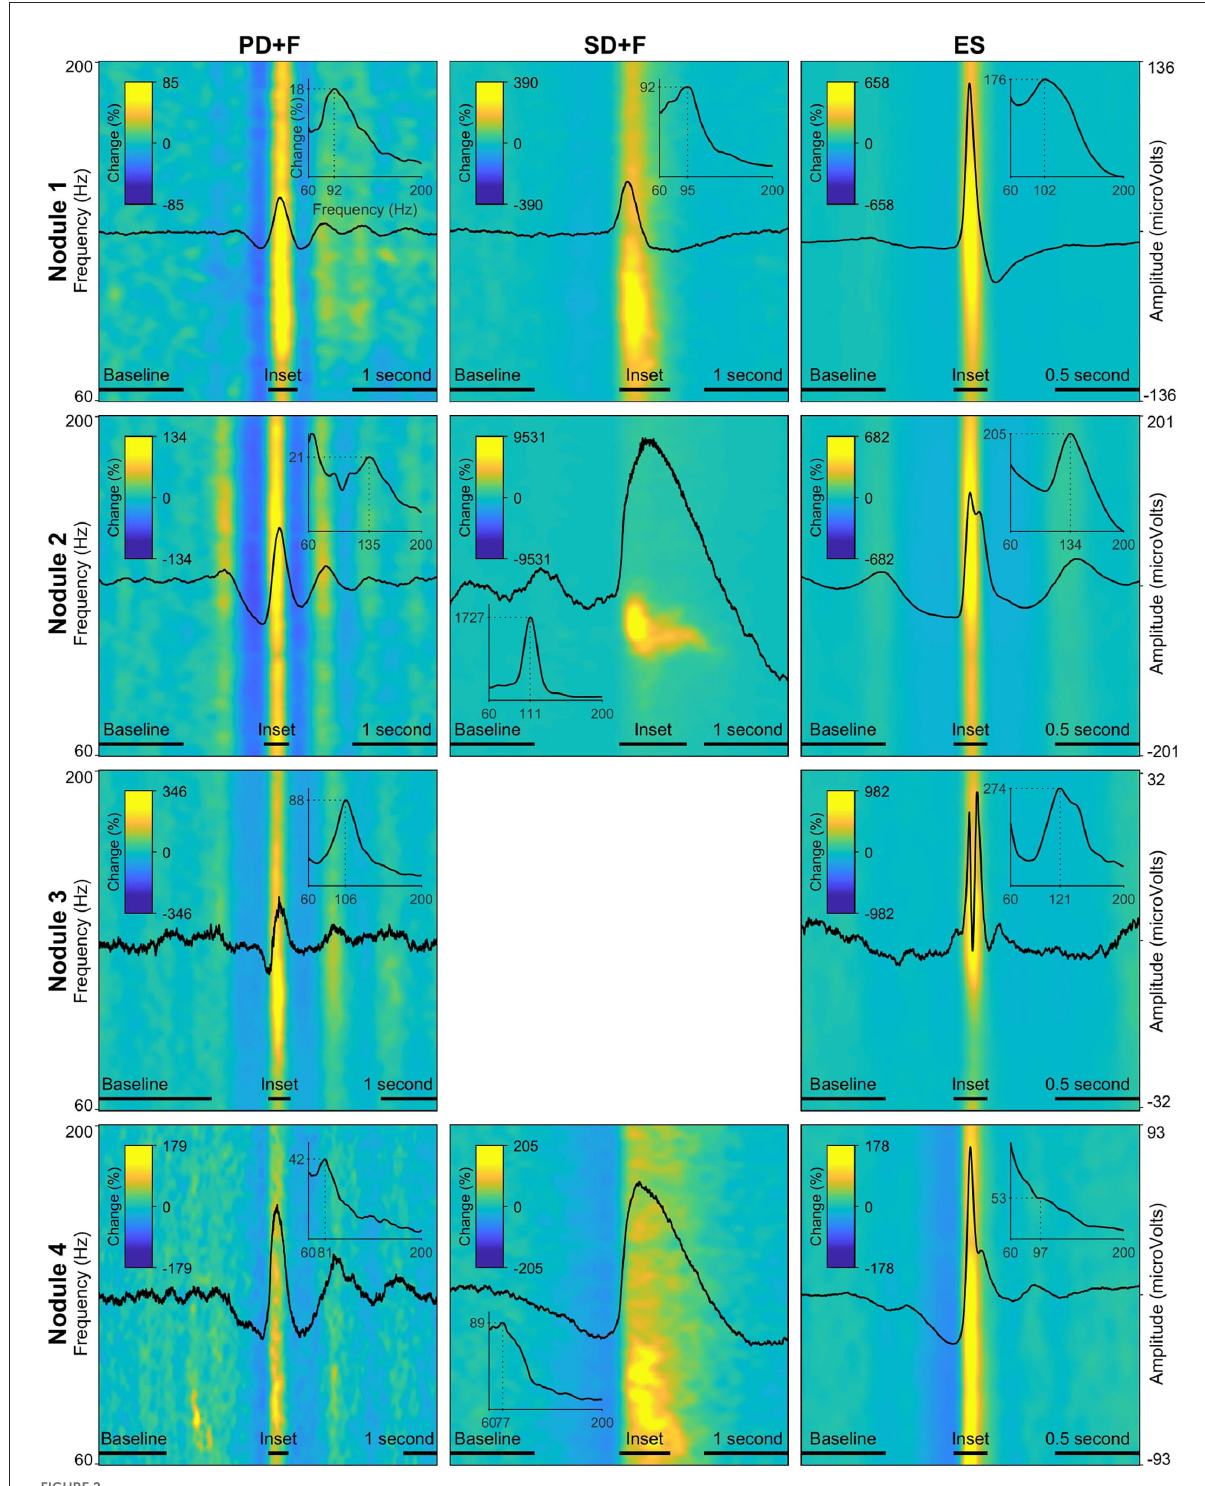
FIGURE2 Local field potentials (LFP) and time–frequency spectra of the interictal patterns. Each row represents one nodule, with every panel/column an interictal pattern, indicated by the panel title. The amplitude of the LFP is scaled per nodule and displayed on the far-right y-axis of every row. The average time–frequency representations (60 Hz − 200Hz) are expressed in percentage change from the baseline period, indicated by the color bar in every panel. Insets show the average power spectra during the peak activity of every pattern, indicated by a horizontal bar above the x-axis. The dotted lines in the inset show peak frequency and % power increased versus baseline. Note that due to the fact that these values are averaged over a time segment, the percentage change is lower than indicated in the time–frequency